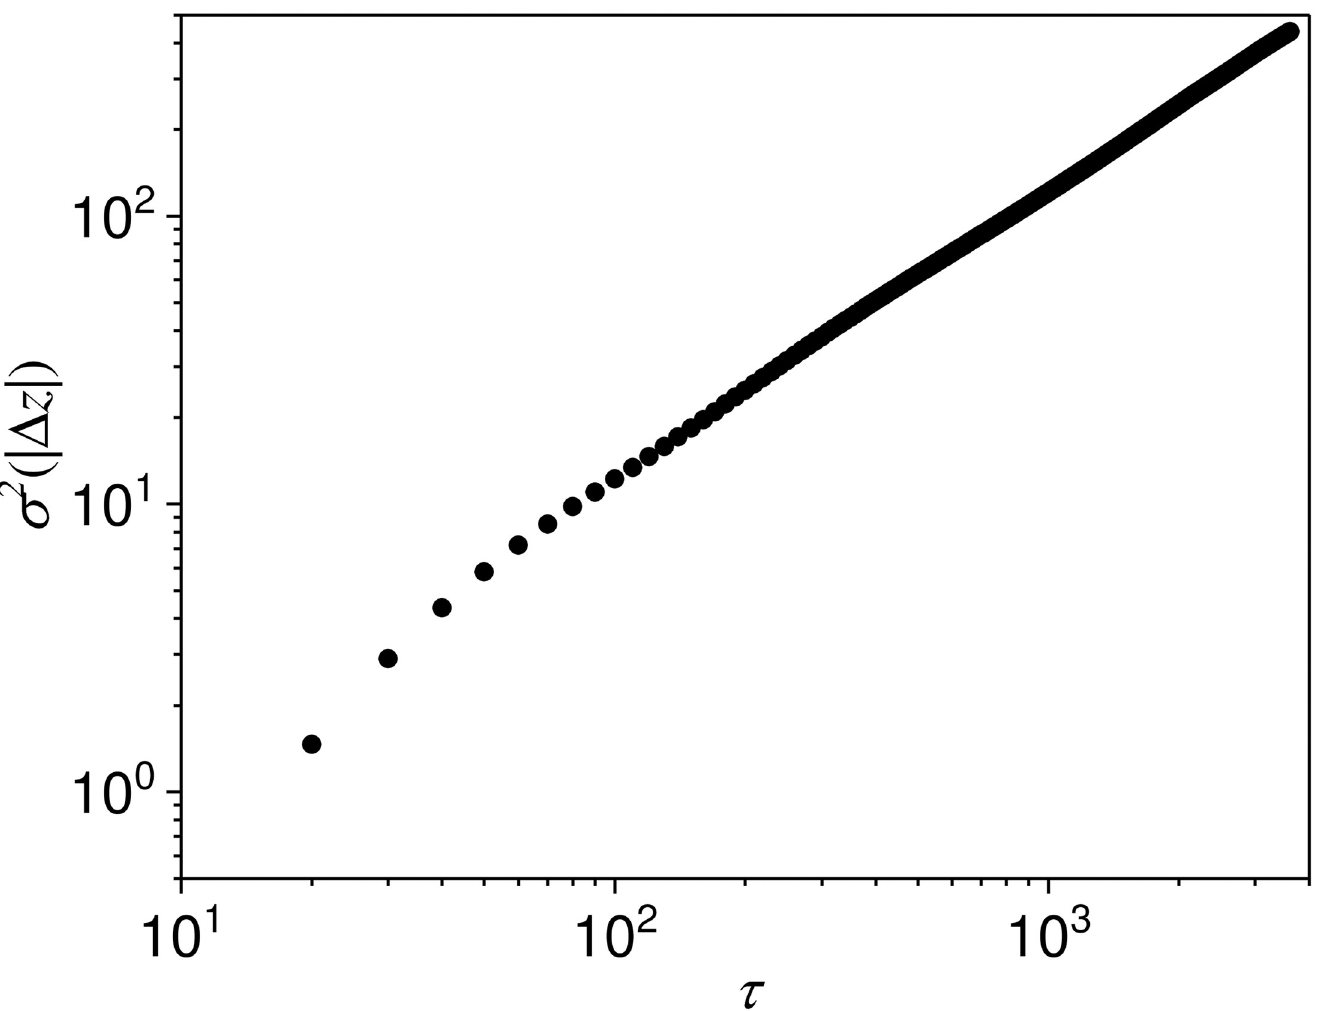
Fig 2. The variance of the change of price versus time interval τ